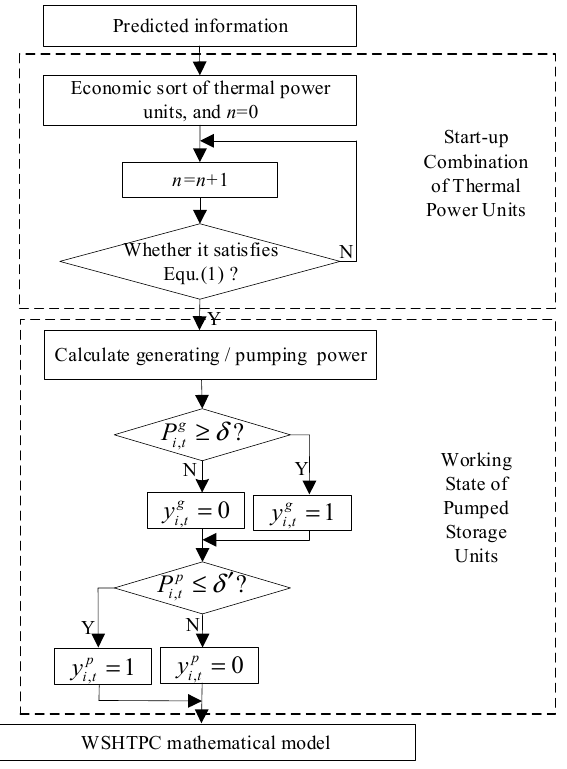
Figure 2. Semi-scheduling Flow Chart.